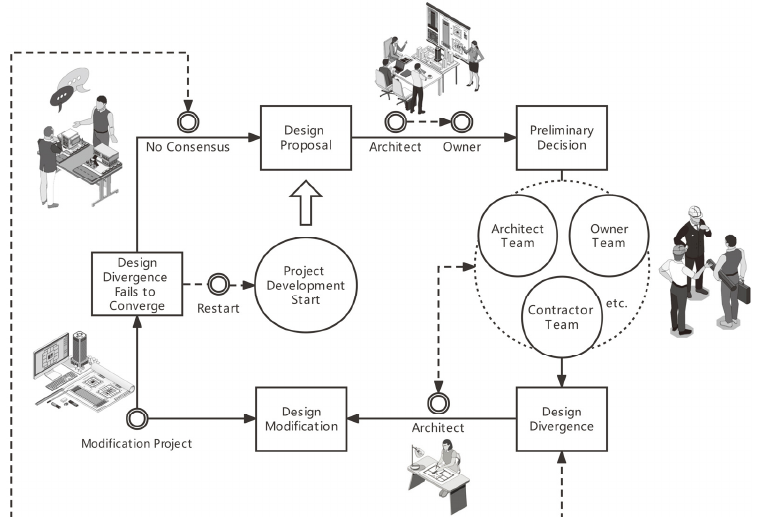
Figure 1. Traditional architectural design process.